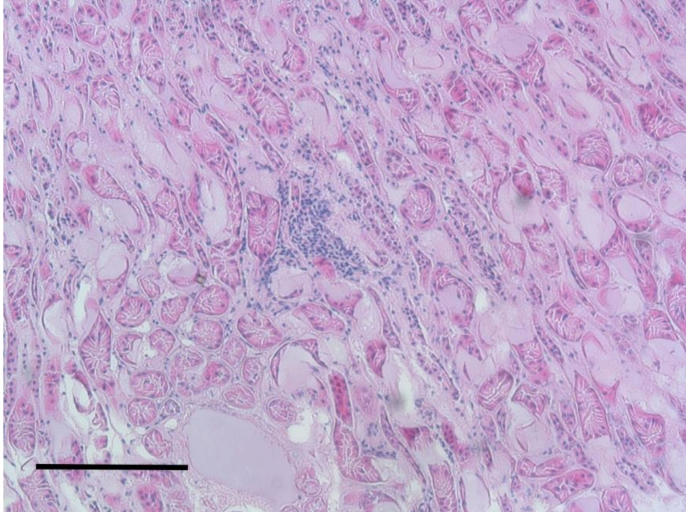
Figure 8. Kidney. Peritubular lymph-plasmacellular inflammation. H&E staining, bar = 100 µ